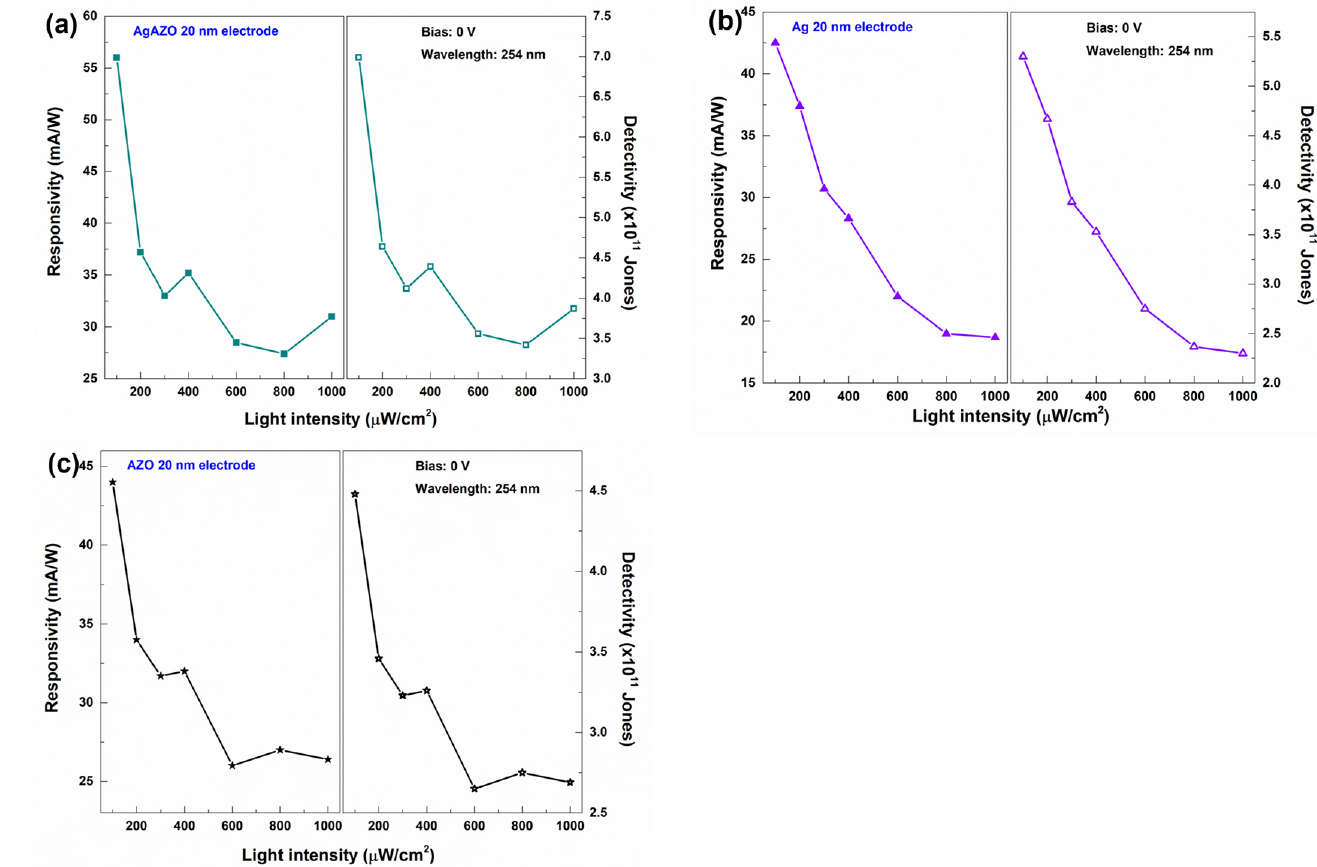
Figure 12. Device responsivity and detectivity change according to light intensity. ( a ) AgAZO 20 nm; ( b ) Ag 20 nm; ( c ) AZO 20 nm.